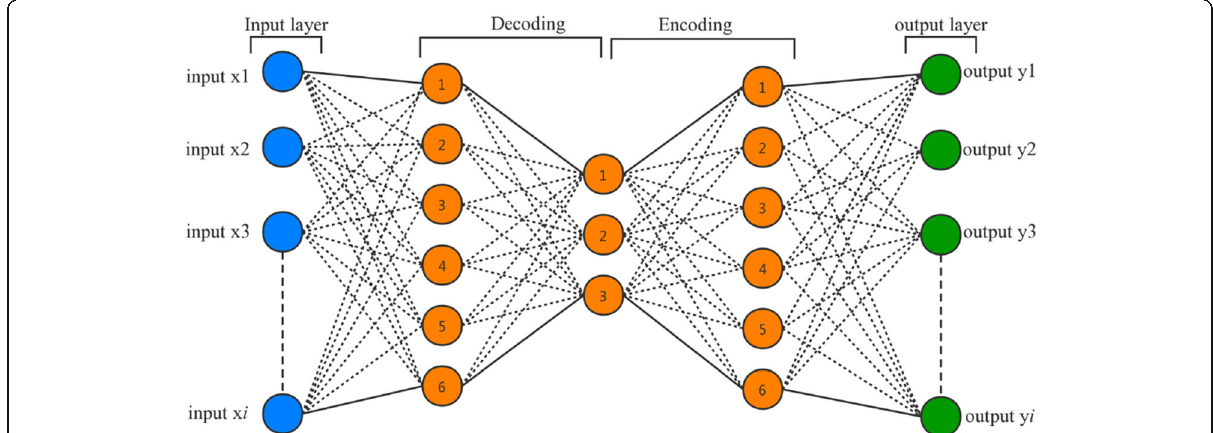
Fig. 2 Schematic of architecture of an autoencoder neural network (the numbers of neurons in the decoding layers and encoding layers are